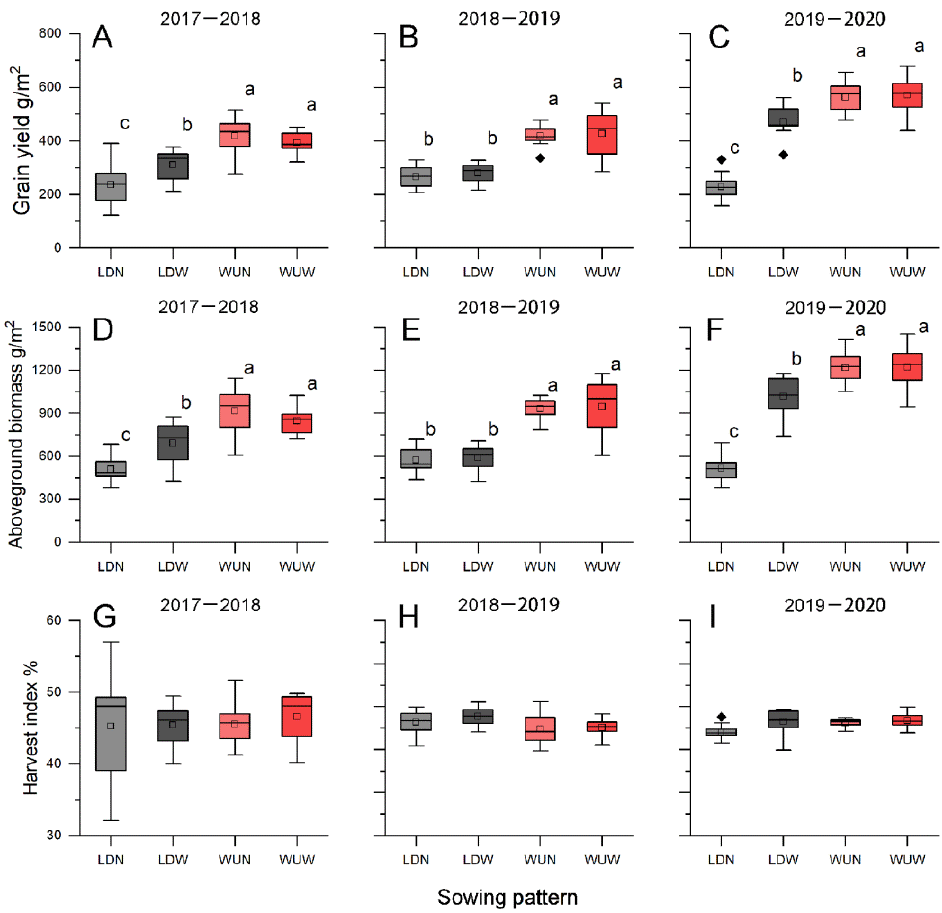
Figure 3. The grain yield ( A – C ), shoot biomass ( D – F ) and harvest index ( G – I ) (HI) of four winter wheat cultivars under four sowing patterns during the growing seasons of 2017–2018, 2018–2019 and 2019–2020. Means ± SE ( n = 3) with the different letters in each figure indicating a significant difference at p = 0.05.